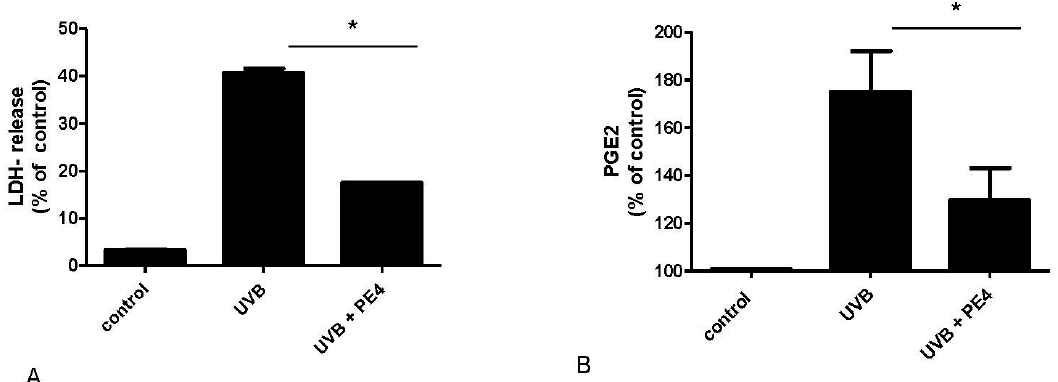
Figure 5. Effect of agrimoniin-enriched fraction PE4 on UVB-induced cell death in vitro and on UVB-induced PGE 2 release in vivo . ( A ) HaCaT cells were incubated for 15 min with PE4 (25 µg/mL) before irradiation with 30 mJ/cm 2 UVB. After 12 h LDH-release was measured to test cytotoxicity of PE4 in HaCaT cells after irradiation. Non-irradiated and untreated cells served as control. Triton X-100 served as positive control and corresponds to 100% LDH release; ( B ) Test areas on the volar skin of healthy volunteers were irradiated with 1.5 MED UVB before treatment for 30 min with 5% PE4. Non-irradiated and untreated test area served as control. After 18 h suction blisters were raised and the blister fluid was (* p < 0.05).